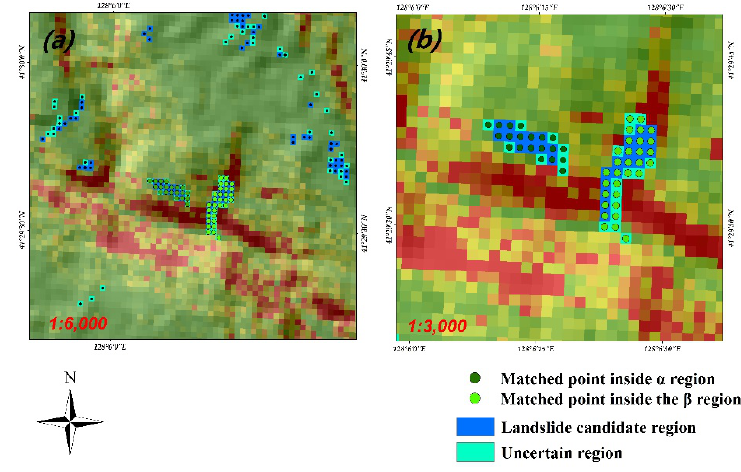
Figure 14. ( a ) Different color point. ( b ) Final results.